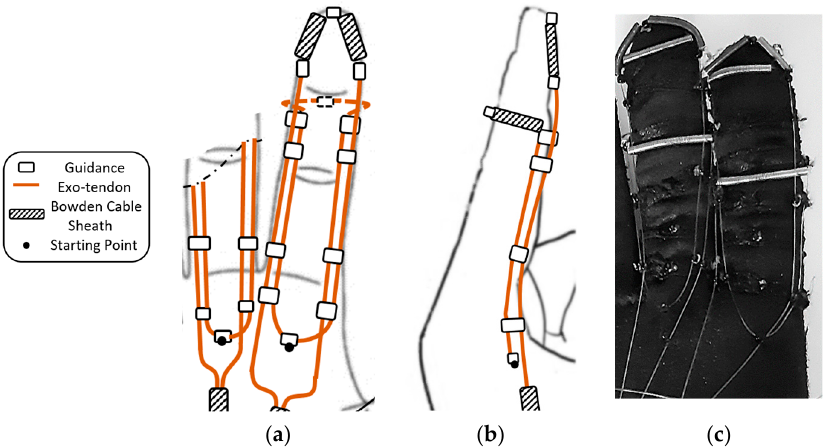
Figure 2. The proposed flexion mechanism, ( a ) Top view (palm side) and ( b ) Side view, including the exotendons paths, the positions of the guidance, the starting point, and the Bowden cable sheaths. ( c ) The soft glove with the mechanism implemented (palm side). Note that part of the extension mechanism is also visible.